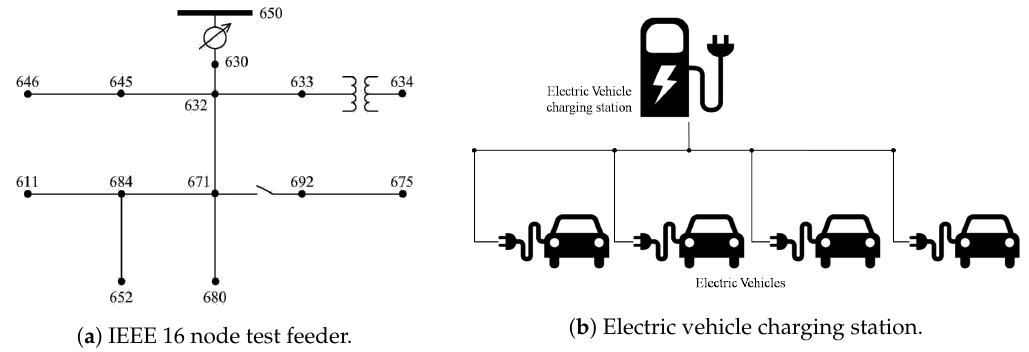
Figure 11. Use cases of the simulation